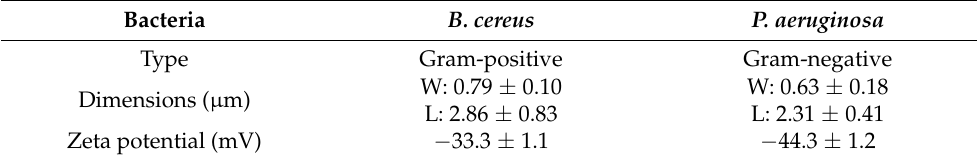
Figure 1. Scanning electron microscopy images of ( a ) B. cereus and ( b ) P. aeruginosa , and ( c ) zeta-potential of these microorganisms. Table 1. The structural and surface characteristics of B. cereus and P. aeruginosa used in this study. ± values indicate the standard